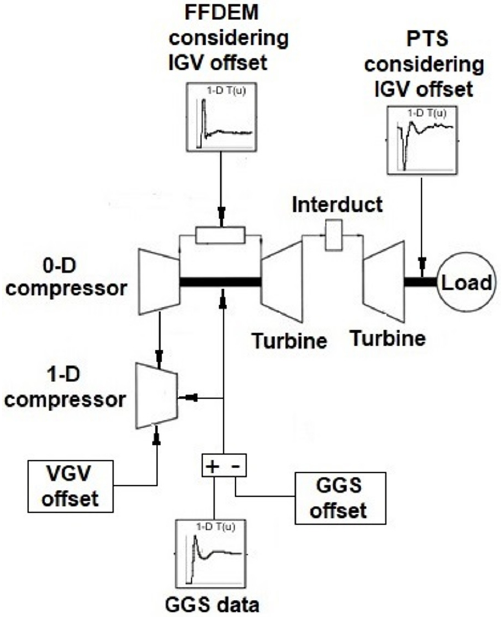
Figure 15. Engine model considering a GGS change during offset in IGV position.